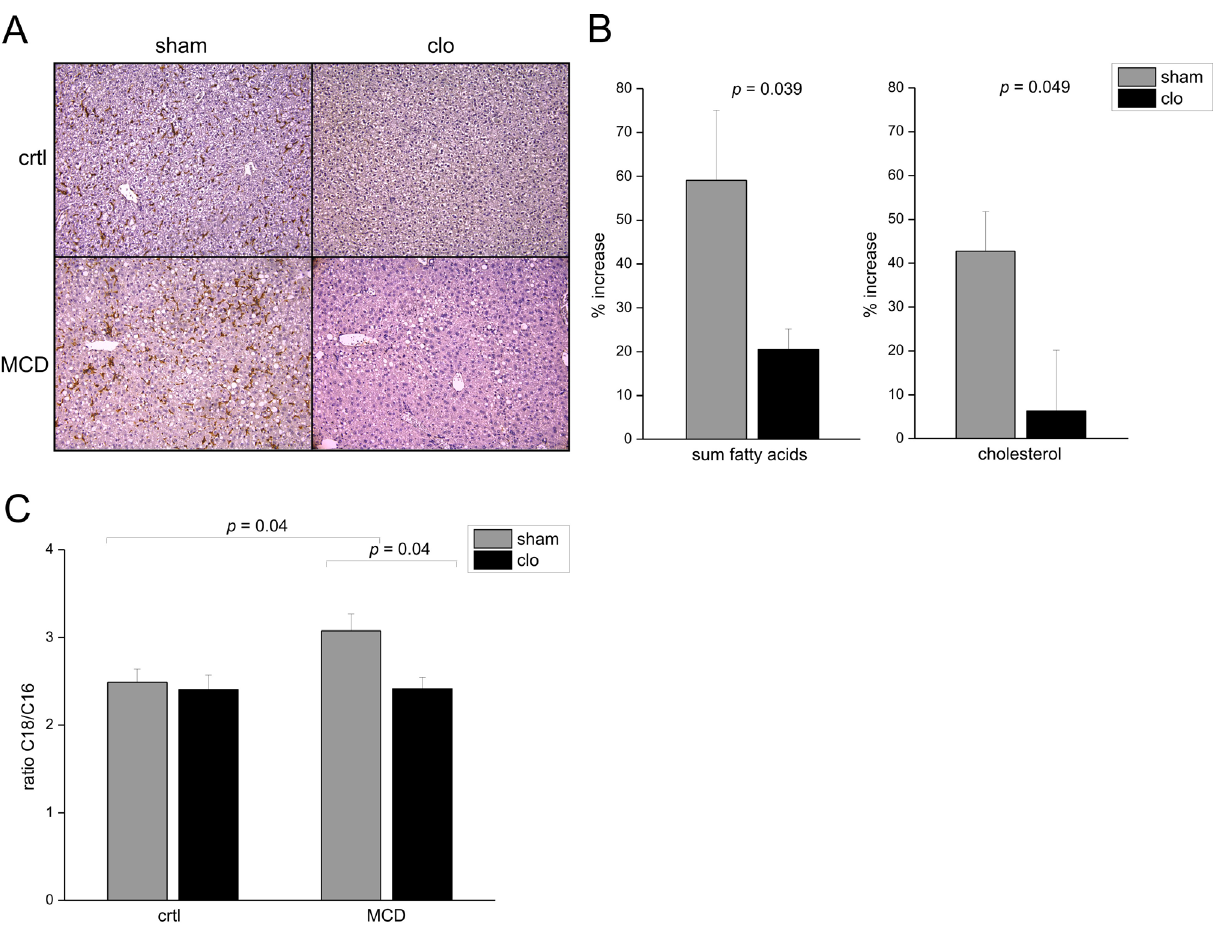
Figure 2. Kupffer cell depletion abrogated elevation of C18 over C16. ( A ) Representative liver sections immunohistologically stained against F4/80 as Kupffer cell marker from animals fed with the respective diet for 3 weeks with simultaneous administration of clodronate (clo) or empty (sham) liposomes (original magnification 200×); and ( B , C ) Increase of the sum of all hepatic fatty acids, hepatic cholesterol ( B ), and ratio of hepatic C18/C16 fatty acids ( C ) of MCD fed animals treated with clodronate (clo) or empty (sham) liposomes compared to ctrl analyzed by GC-MS ( n =